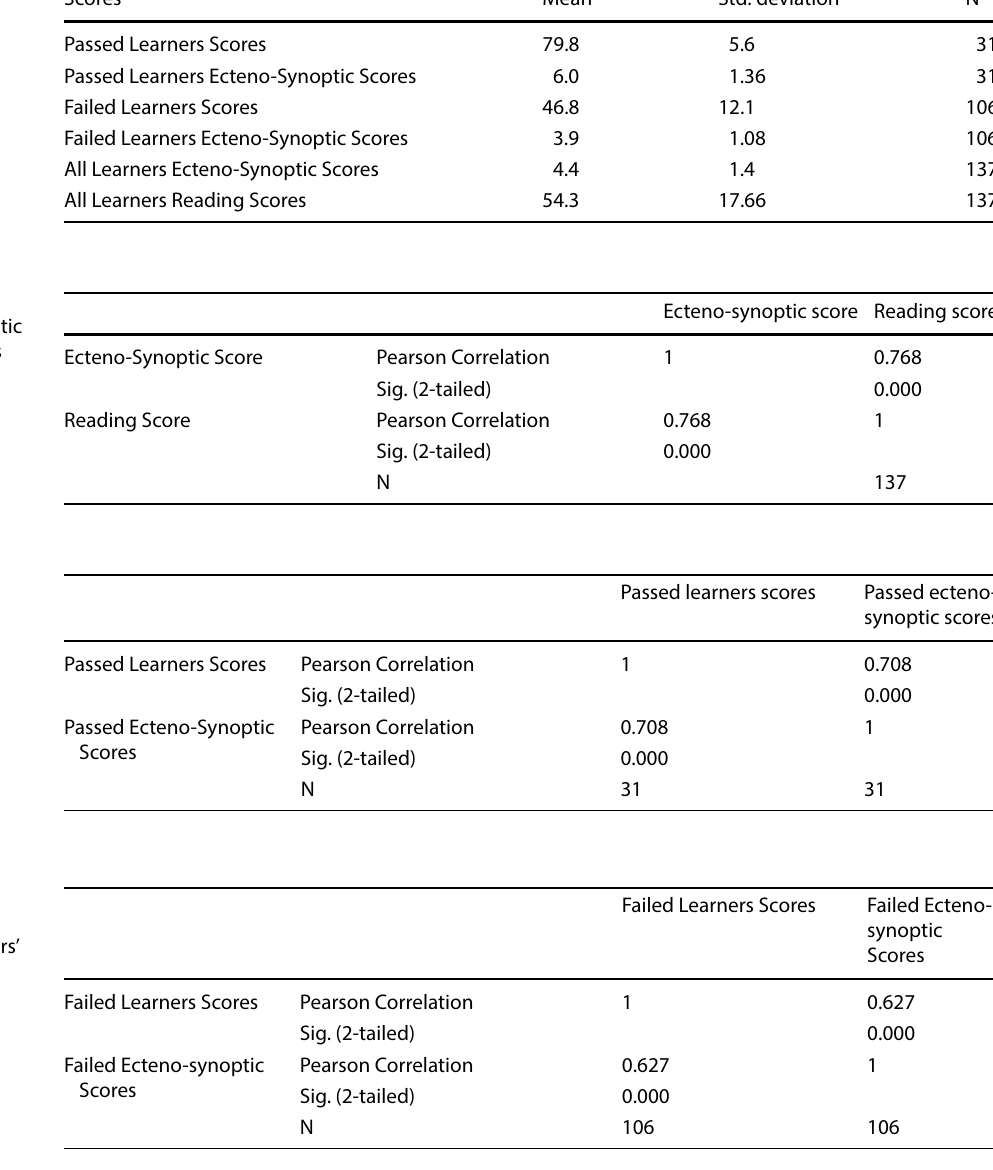
Table 1 Learners’ Learning styles and Reading Performance Descriptive Statistics